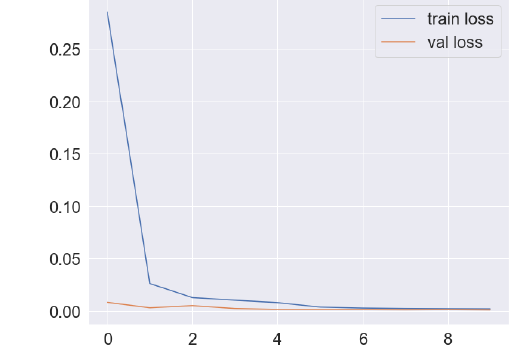
Fig. 13 Validation Two Class Accuracy Fig. 14 Validation Two Class Loss